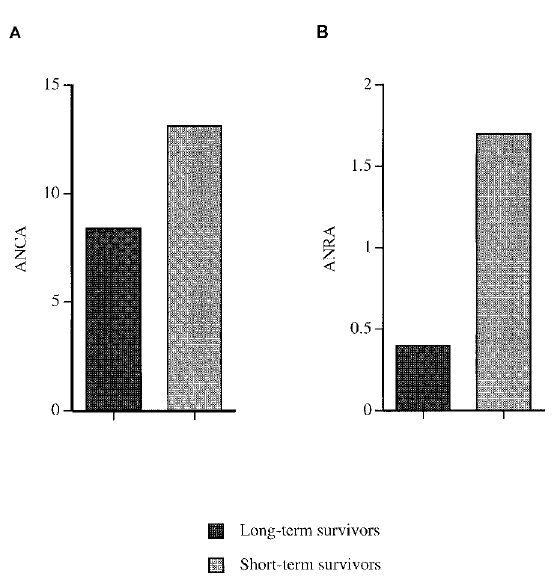
Fig. 3. (A) Average number of chromosomal aberrations (ANCA) and (B) average number of regional amplifications (ANRA) in pri- mary breast carcinomas from patients with short- and long-term sur- vival. sion from primary tumor to recurrences/local lymph node